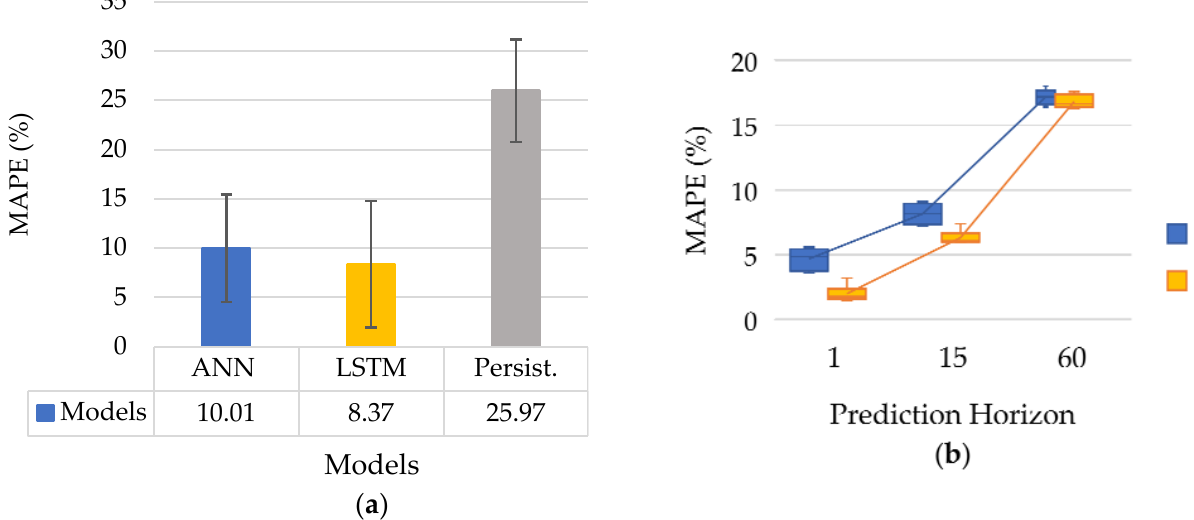
Figure 4. Prediction accuracy of ANN and LSTM models: ( a ) mean overall accuracy for all samples of each model, and ( b ) mean model accuracy by prediction horizon.